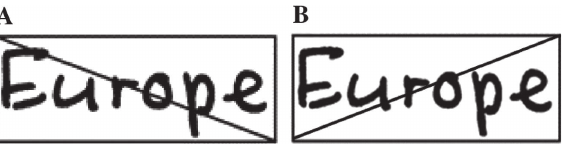
Figure 8: Showing Hypothetically Generated Sub-images by Segmenting an Image Along (A) Principal and (B) Non-principal